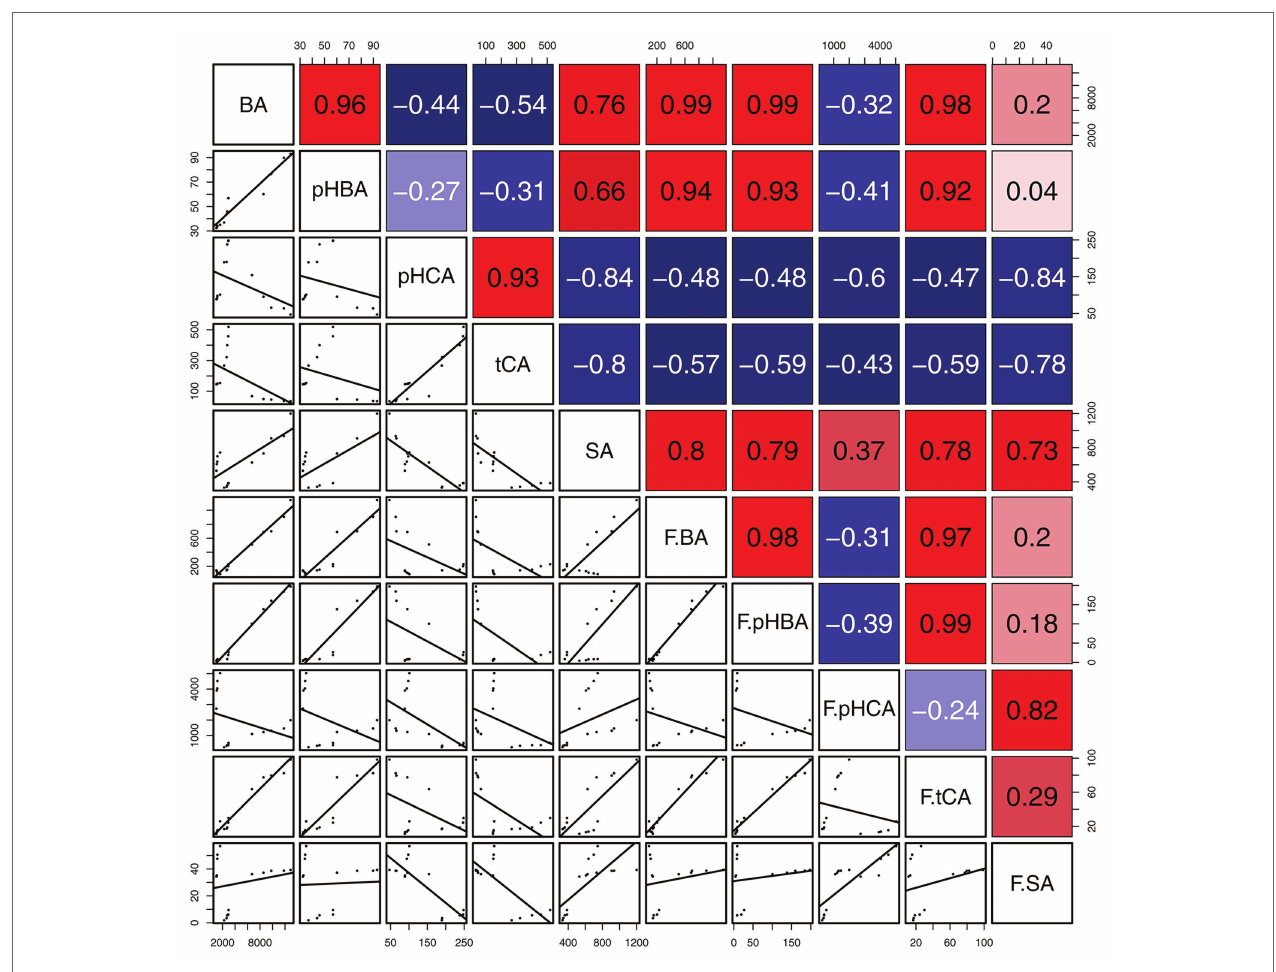
FIGURE 9 | Correlation of SA and SA-related phenolics between gall tissues and cones. The mean differences were compared using t -tests ( p < 0.05). BA, p HBA, p HCA, t CA, and SA represent the levels of phytohormones in gall tissues; F.BA, F. p HBA, F. p HCA, F. t CA, and F.SA represent the phytohormone levels in cones. Red and blue boxes represent positive and negative correlations,